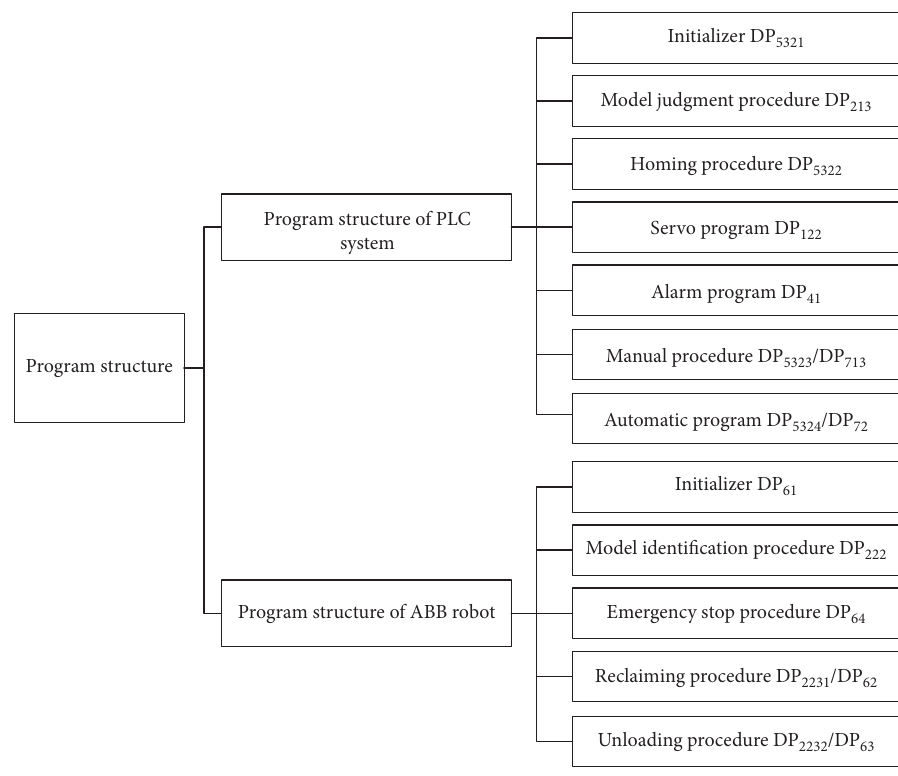
Figure 12: Control service system’s program structure scheme.